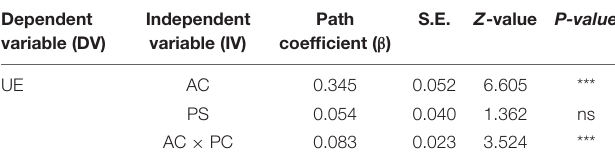
TABLE 5 | Model fit criteria and the test results.